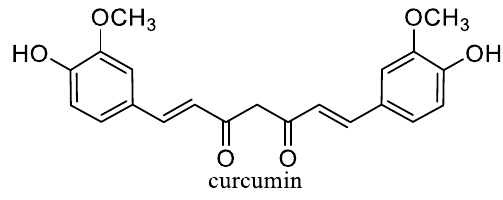
Figure 6. Structure of curcumin.